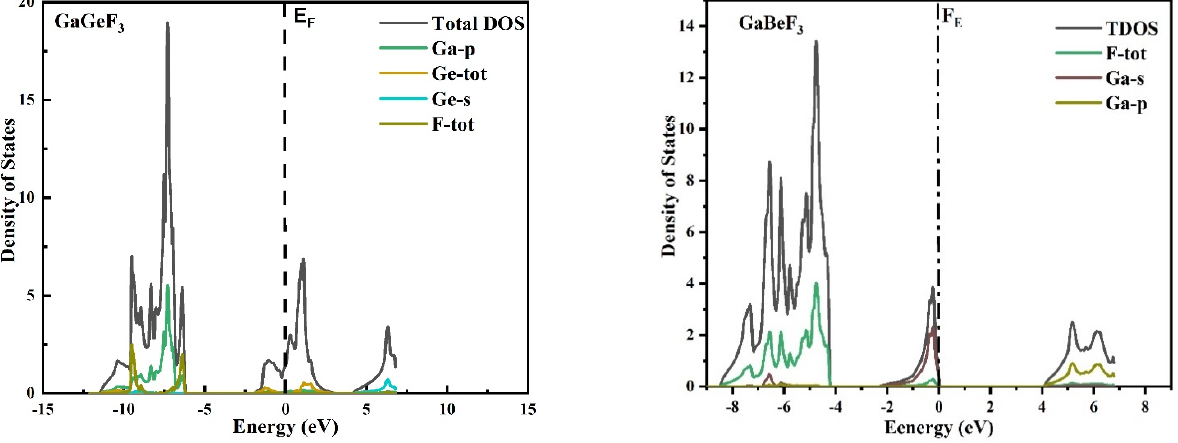
Figure 4. The TB-mBJ approximation approach was used to calculate the TDOS and PDOS of the GaMF 3 (M = Ge and Be) compounds.